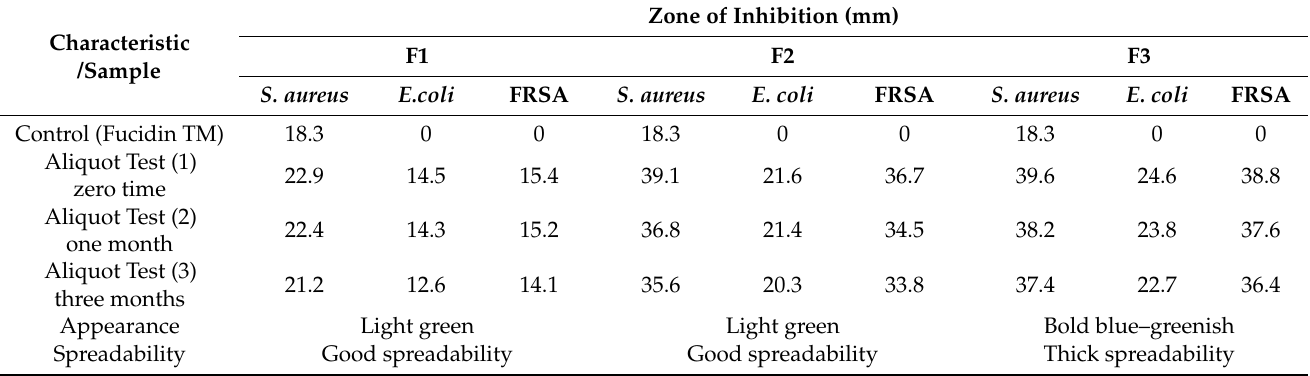
Table 2. Evaluation of different topical formulations at 0, 1, and 3 months at accelerated conditions (40 ± 2 ◦ C/75% ± 5% RH).